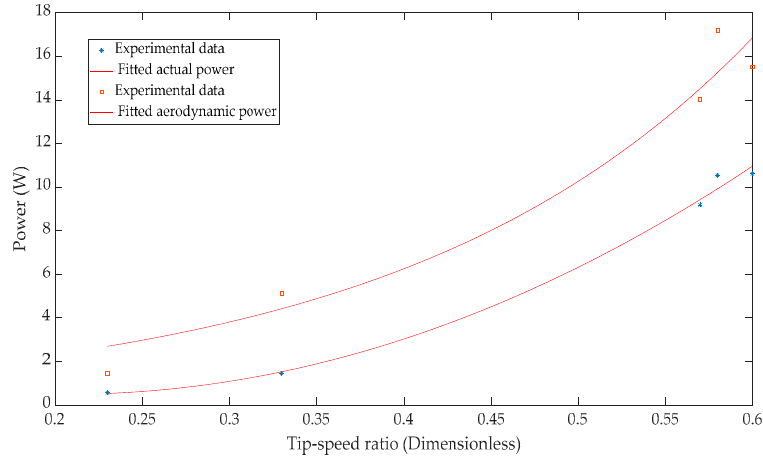
Figure 10. Power output as a function of the tip-speed ratio.